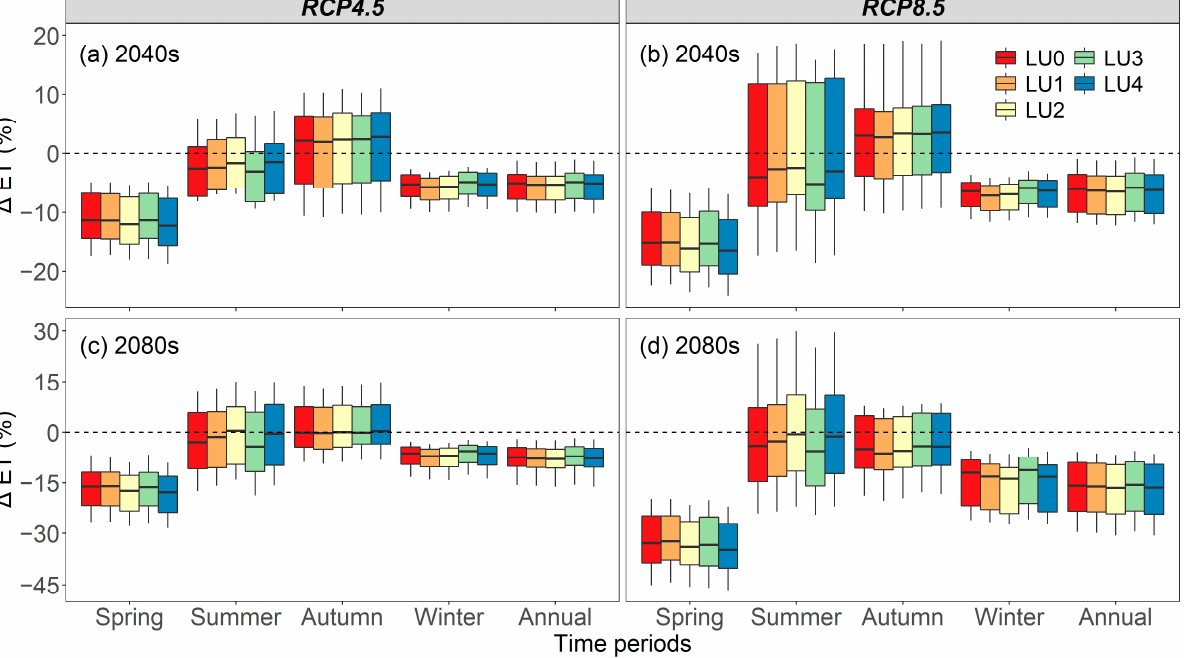
Figure 9. Projected seasonal and annual changes in soil water (%) for LU0 − LU4 in the 2040s and 2080s under both RCPs estimated from 34 GCMs compared to the baseline period. Data displayed are changes in the 40 − year averages for each of the 34 GCMs. The lower and upper whiskers show the 10th and 90th percentiles; box boundaries show the 25th and 75th percentiles; the black line within each box marks the median values.